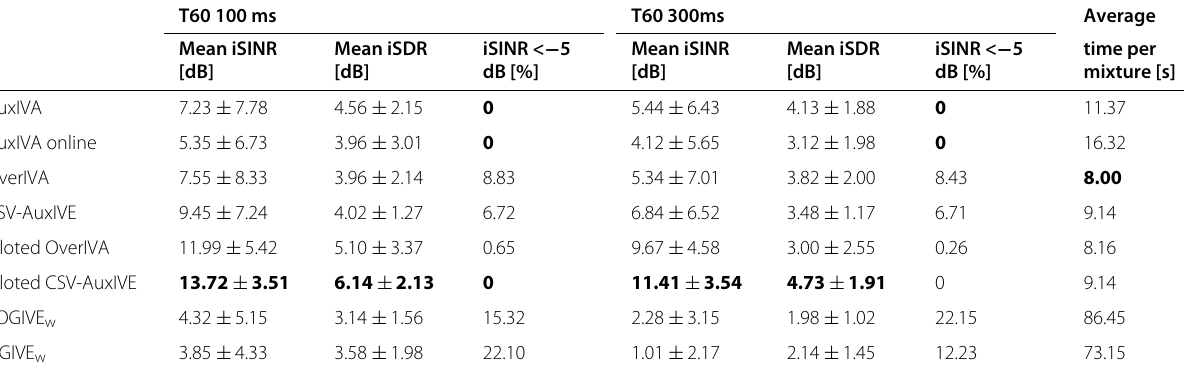
Table 4 The SINR improvement with standard deviation, SDR improvement with standard deviation and extraction fail percentage for the MIRaGe database